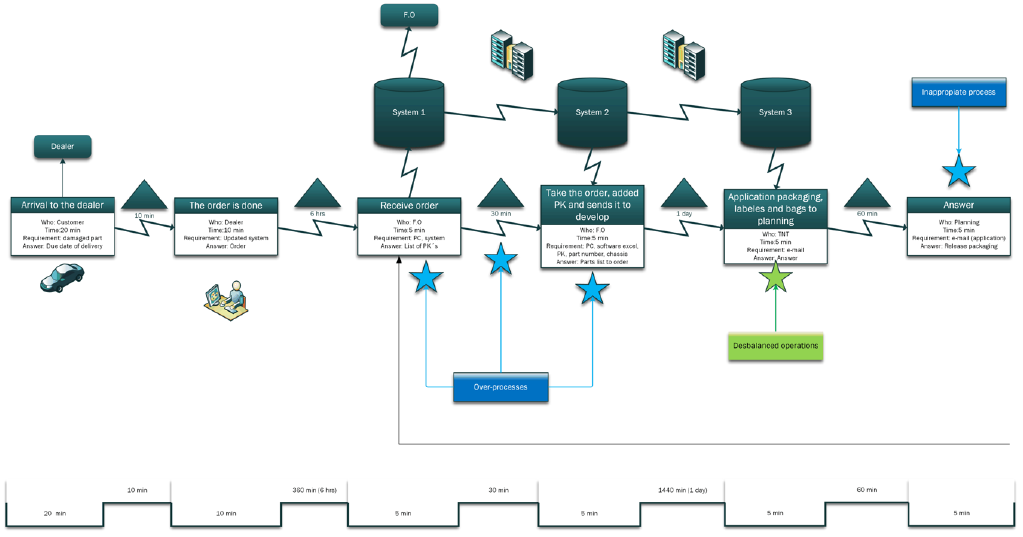
Figure 10. The first part of seven of the Current State Value Stream Map with wastes.